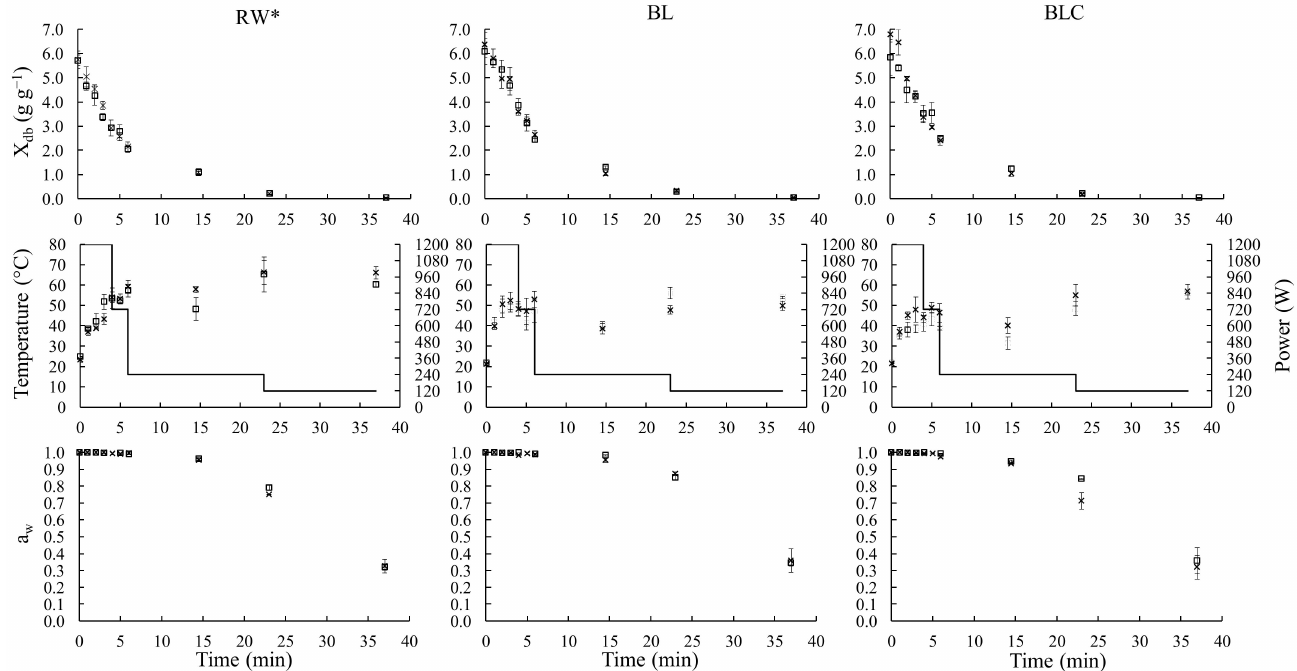
Figure 1. Variation of moisture content ( X db ), temperature, microwave power (–) and water activity (a w ), during the two drying repetitions of RW, BL, and BLC samples. ( (cid:3) , × ) Symbols indicate the duplicate of the drying process. * Data from Gomide et al.